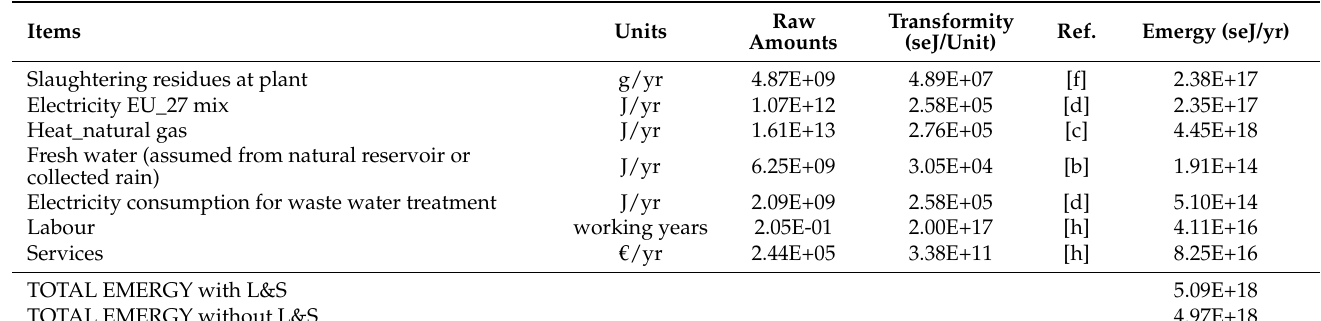
Table 3. Emergy table for rendering I.